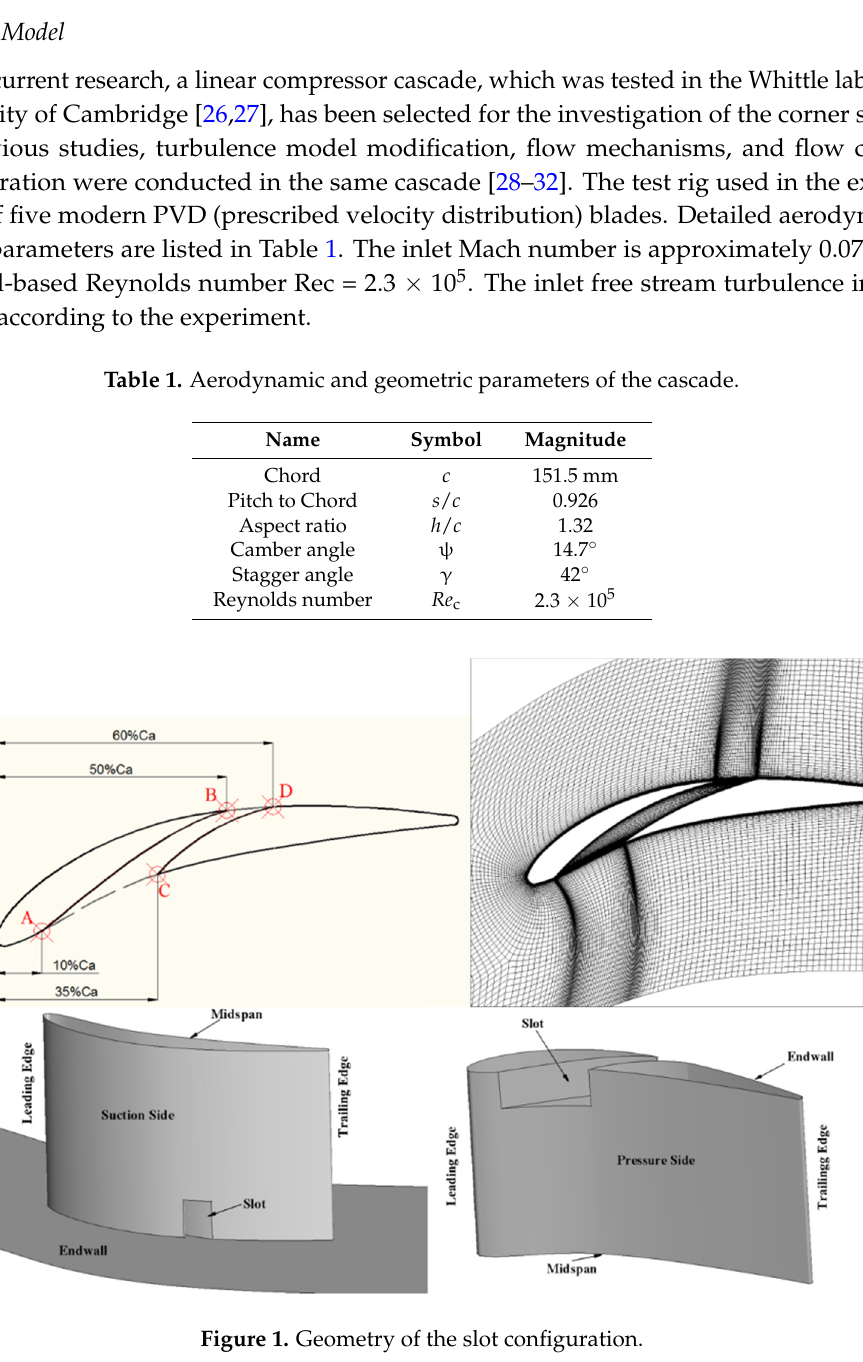
Figure 1. Geometry of the slot configuration.